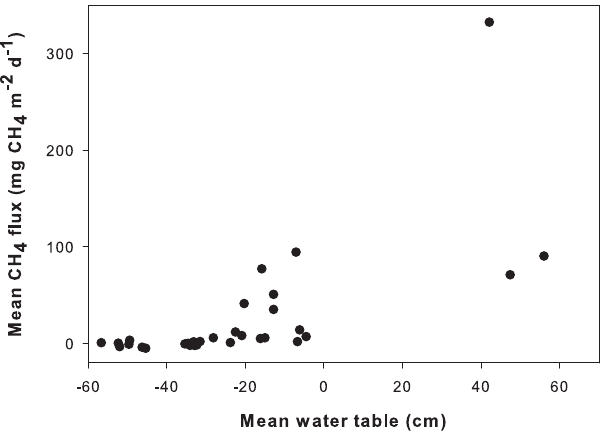
Fig. 6. Mean growing season methane flux versus mean growing season water table position including all natural, restored and unre- stored plots. Negative water table indicates a water level below the soil